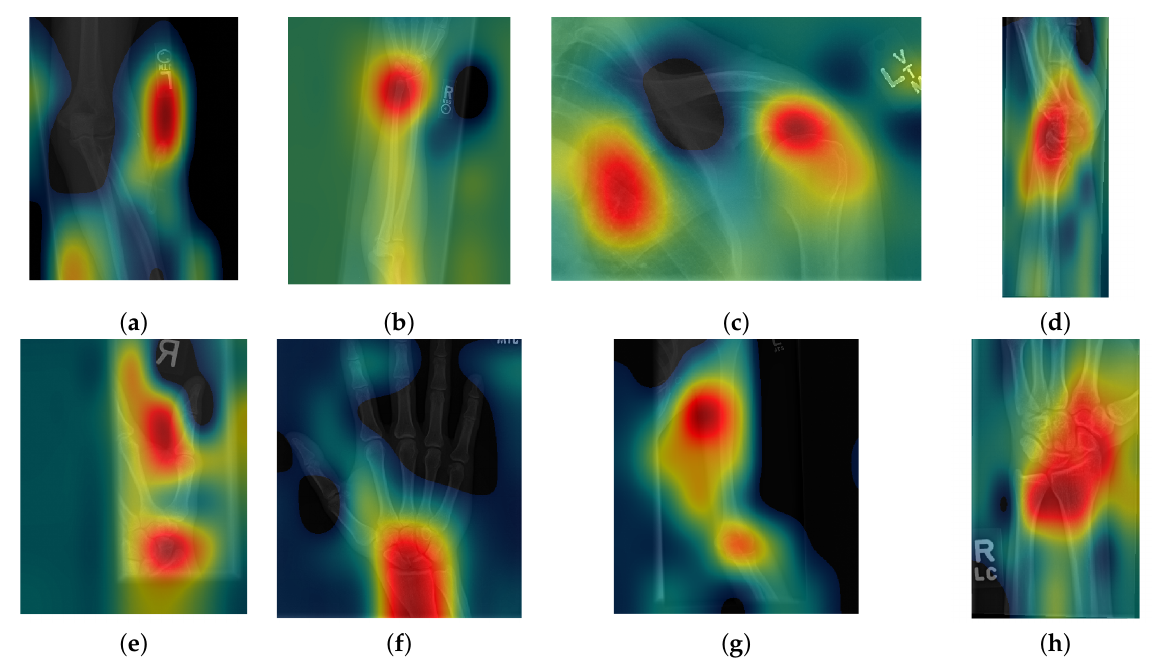
Figure 7. Illustration of activation maps overlaid over the eight radiographs without abnormalities of Figure 1 to indicate the regions of the image that activated a ResNet 50 architecture. ( a ) Elbow, ( b ) Forearm, ( c ) Shoulder, ( d ) Wrist (lateral view), ( d ) Lateral view of Wrist, ( e ) Finger, ( f ) Hand, ( g ) Humerus, ( h ) Wrist. As these cases are positive (no abnormality), the regions of activation are not as critical as those with abnormalities.